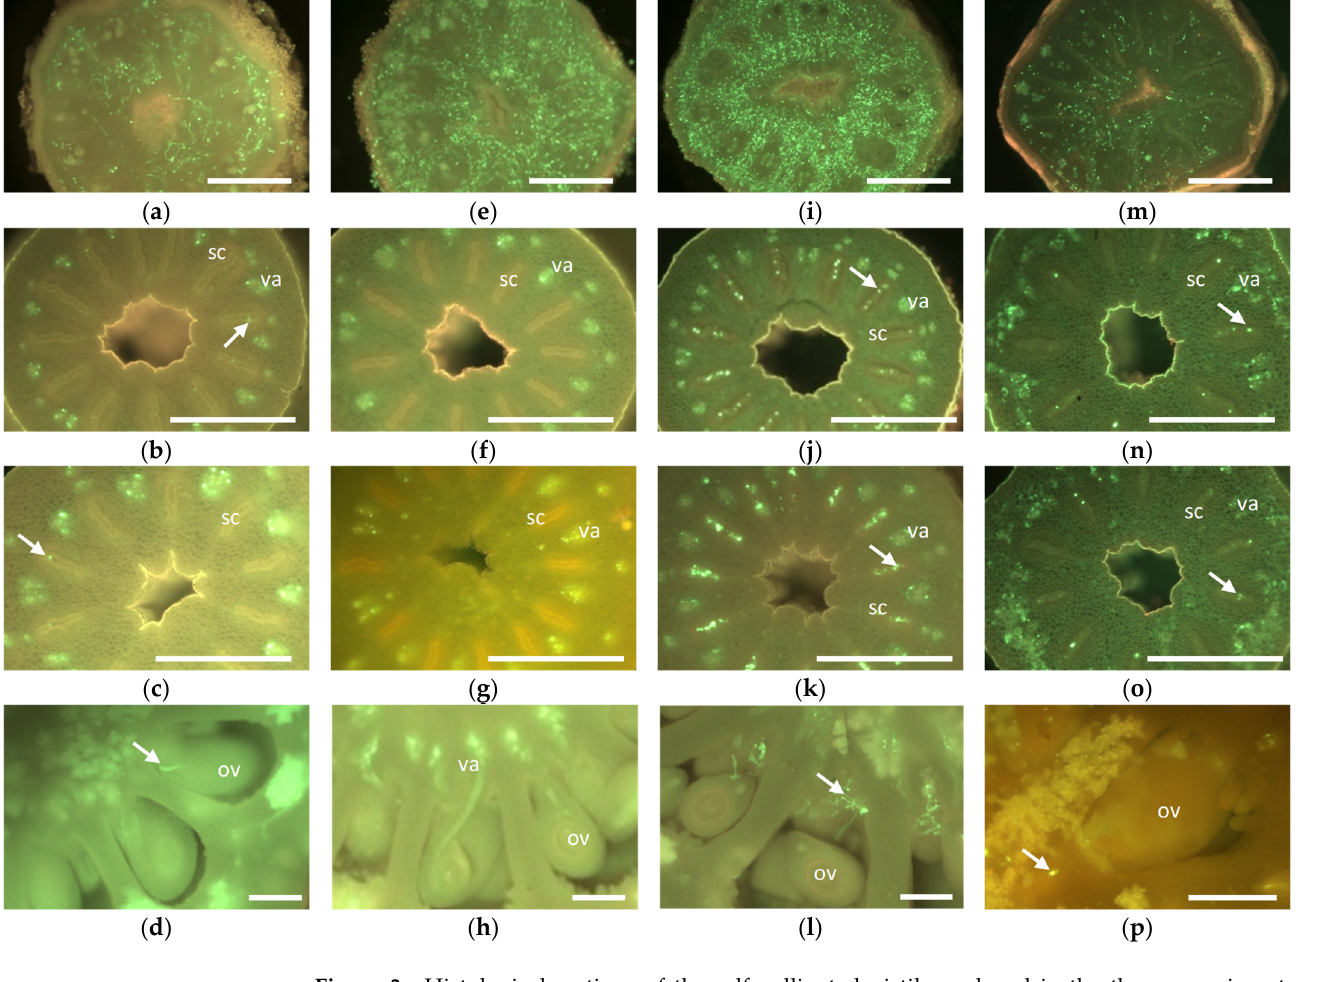
Figure 3. Histological sections of the self-pollinated pistils analyzed in the three experiments. ( a – d ) Self-pollinated pistil of ‘Fortune’ mandarin at 10 °C. ( e – h ) Self-pollinated pistil of ‘Fortune’ mandarin at 30 °C. ( i – l ) Self-pollinated buds of ‘Fortune’ mandarin. ( m – p ). Self-pollinated pistil of the tetraploid ‘Clemenules’ clementine. Pollen tubes are marked by an arrow; va: vascular axis; sc: stylar canal; ov: ovule. Scale bars are depicted by white lines: ( a , e , i , m ) 1 mm; ( b , c , f , g , j , k , n , o ) 0.5 mm; ( d , h , l , p ) 0.2 mm.